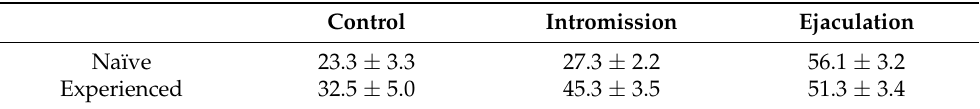
Table 1. The proportion of pERK expression in GRP-immunoreactive neurons (%) after sexual